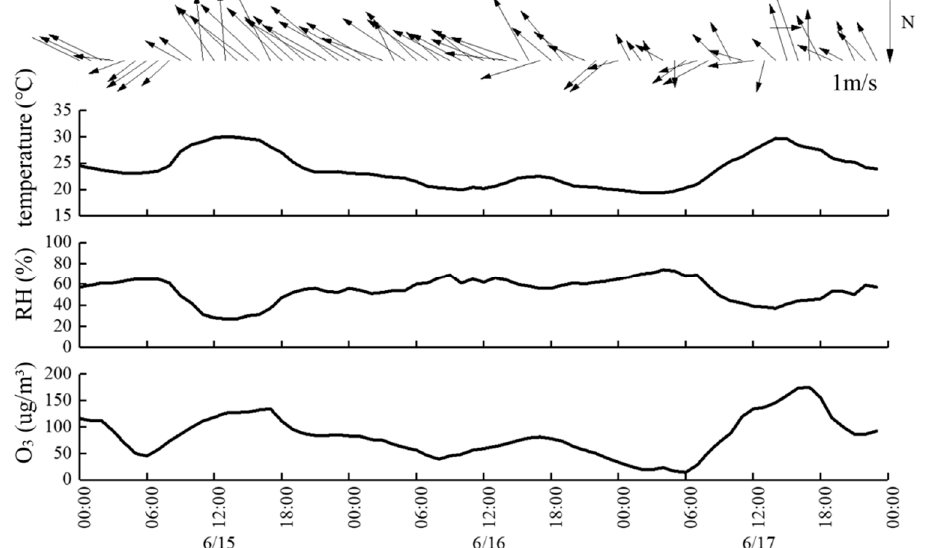
Figure 9. Diurnal variation of pollutant concentration and meteorological element from June 15 to 17.